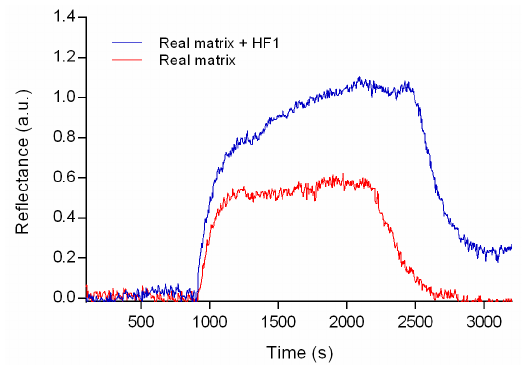
Figure 6. SPR sensograms evaluating the level of nonspecific signals due to matrix effects resulting from banana leaves extracts.